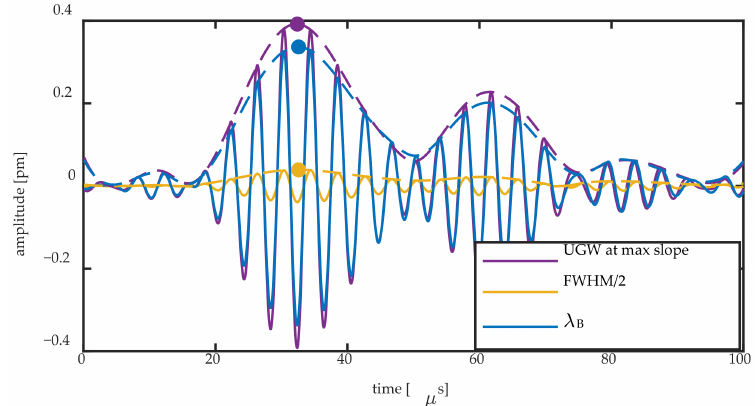
Figure 11. Bragg wavelength shift and FWHM / 2 change of the 8-mm FBG during the passage of a 250 kHz UGW obtained by the Gaussian fit compared to the UGW measured at the steepest slope. The Hilbert transform of all signals is shown by a dashed line, and the maximum amplitude of the latter is shown by a full dot in the same color.